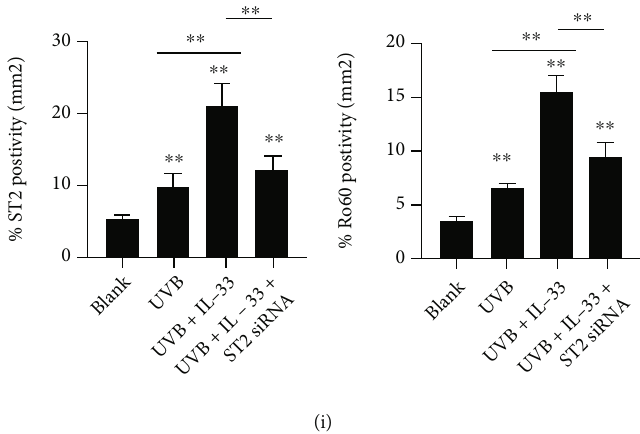
Figure 2: IL-33 promotes proin fl ammatory cytokine secretion and Ro60 expression in murine KCs upon UVB irradiation. In vitro , the PAM212 KCs were subjected to UVB irradiation, either alone or combined with IL-33 and bovine serum albumin (BSA) stimulation. (a) qRT-PCR determination of ST2, SOX17, CCL2, RANTES, ICAM-1, MCP-1, and IP-10 mRNA expression in KCs. (b) qRT-PCR detection of Ro60 mRNA in KCs. (c) Western blotting detection of Ro60 protein in cell lysates and supernatants of KCs. (d) Densitometry analysis of Western blotting bands of supernatant Ro60. (e) Densitometry analysis of Western blotting bands of cell lysate Ro60. (f) Western blotting analysis of Ro60 in cells transfected with ST2 siRNA or control siRNA and subjected to UVB and IL-33 treatments. (g) Densitometry analysis of Western blotting bands of Ro60 in ST2 siRNA- or control siRNA-transfected cells with UVB and IL-33 treatments. (h, i) Immuno fl uorescence analysis of ST2 and Ro60 in KCs subjected to di ff erent treatments. Data were obtained from three experiments conducted independently. Data points and error bars denote mean ± SEM . Bar = 5 μ m . ∗ p < 0 : 05 , ∗∗ p < 0 : 01 , and ∗∗∗ p < 0 : 001 . KC: